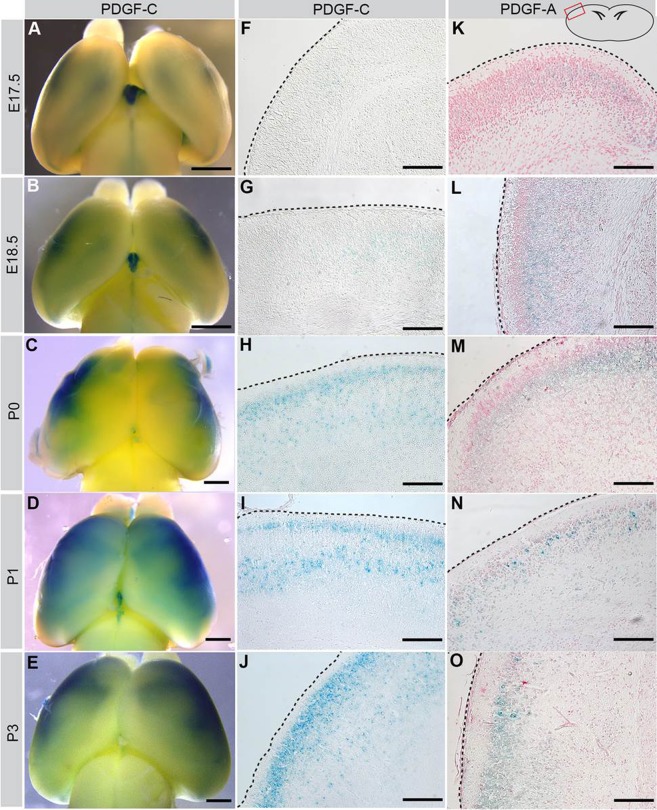
Perinatal expression of PDGF-C and PDGF-A in cerebral cortex. (A-E) Whole mount X-gal staining of Pdgfc+/− brains, visualizing how PDGF-C expression increases with age. (F-O) Coronal sections of whole mount X-gal stained brains counterstained with Nuclear Fast Red. Illustration in upper right corner shows where the photos are taken, and black dotted lines mark the cortical surface. (F-J) Increasing expression of PDGF-C (blue) close to the cortical border. (K-O) PDGF-A expression (blue) largely overlaps with PDGF-C expression. Scale bar: 1 mm in A-E, 150 µm in F-O.